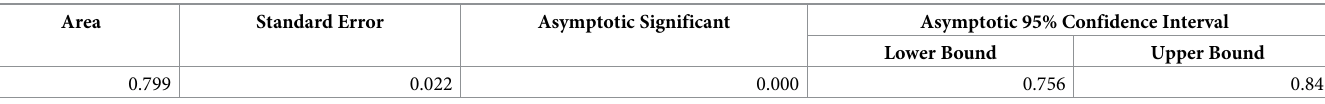
Table 3. Area under the curve based on data from March 29,